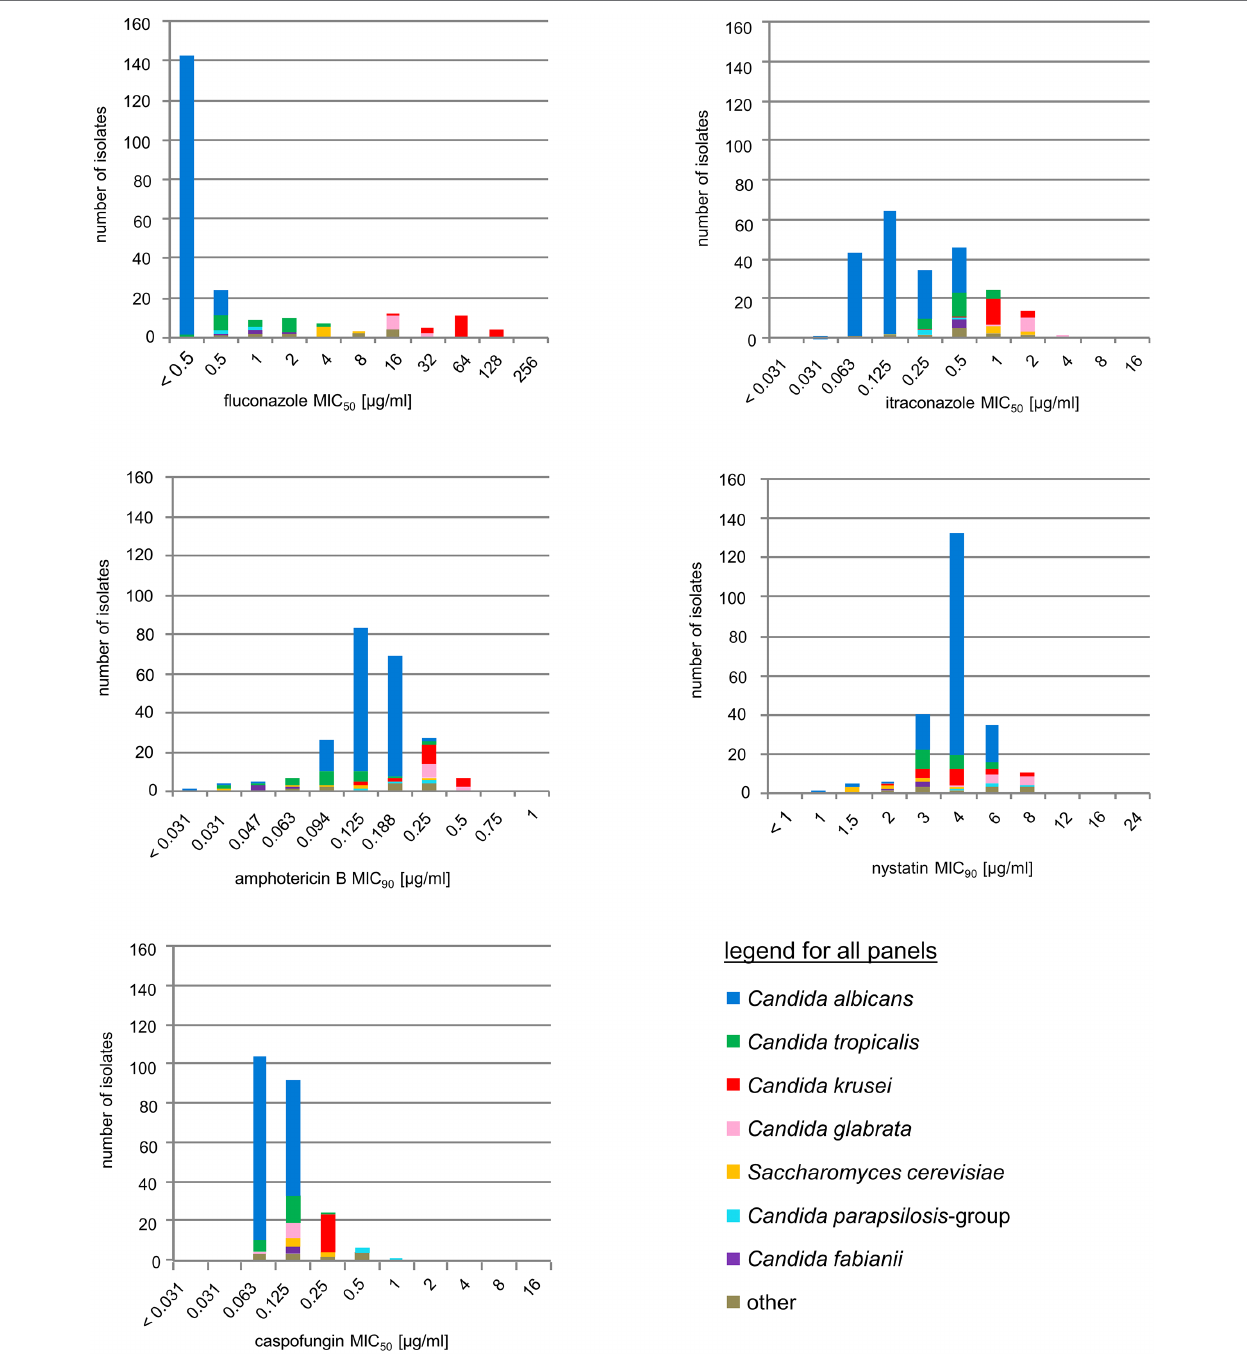
FIGURE 5 | Antifungal drug resistance. Susceptibility distribution to five common antifungals, stratified by species. For color codes see inset, species-specific breakpoints are briefly outlined in the Methods